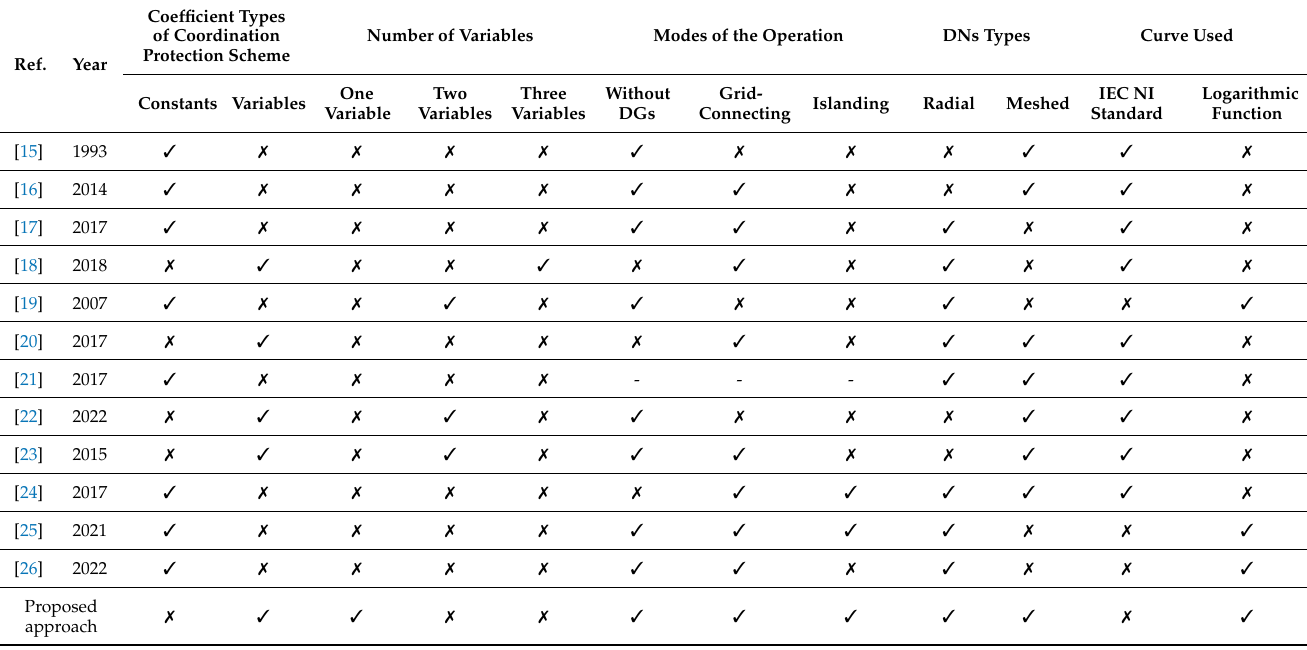
Table 1. A Literature Review Comparison Analysis for Protection of Radial and Meshed Networks.